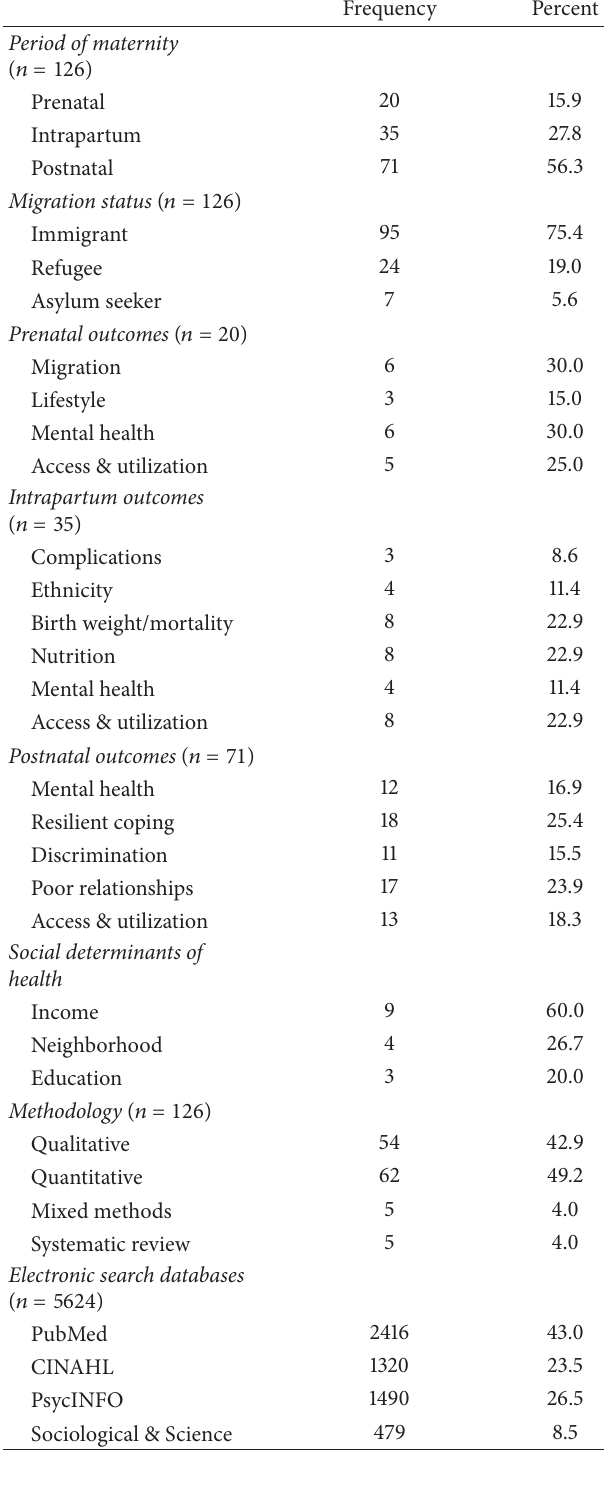
Table 2: Content of studies and database